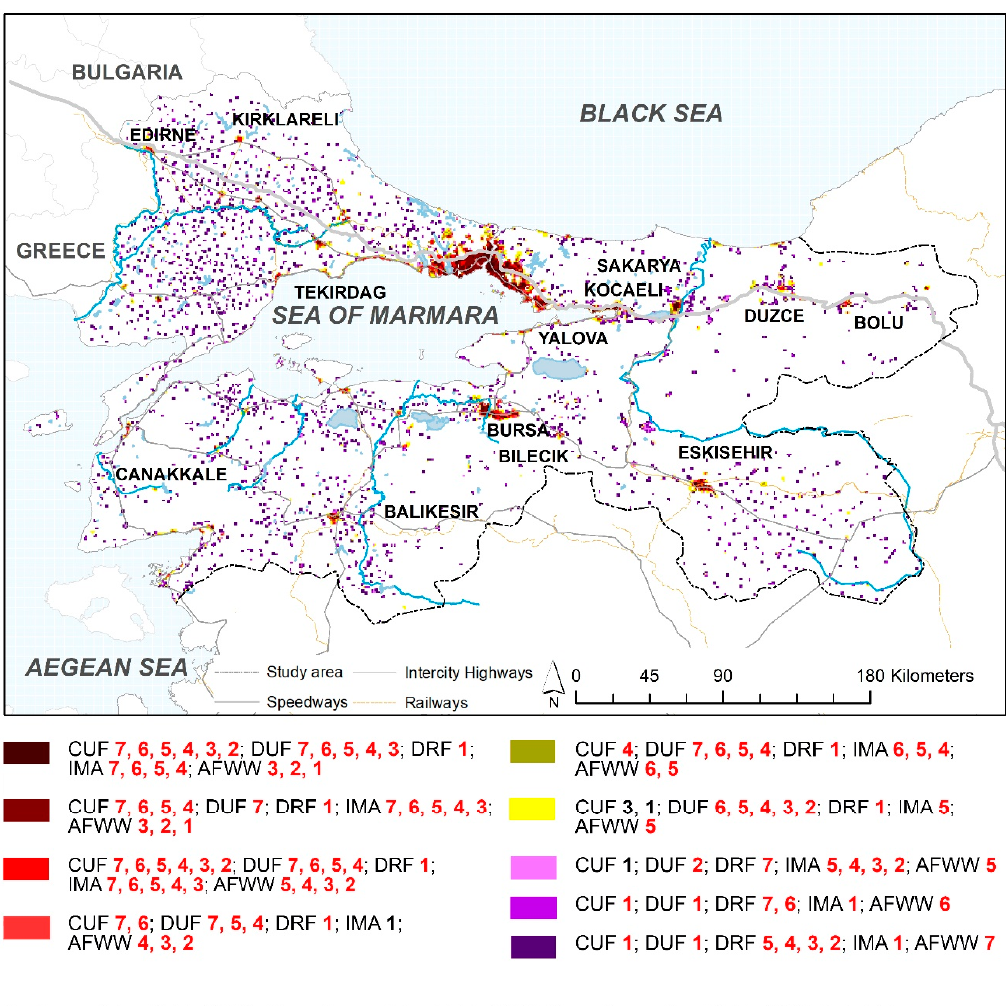
Figure 7. Urban fabric land cover composition in 2006.